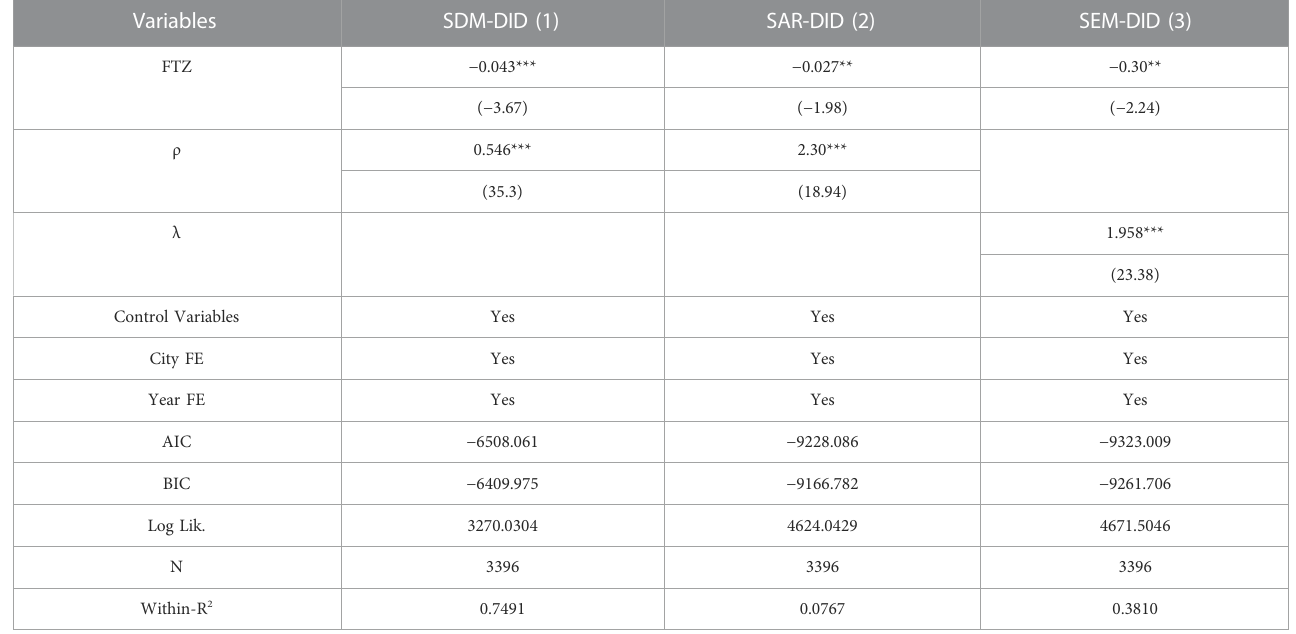
TABLE 9 Results with adjacency spatial matrix.